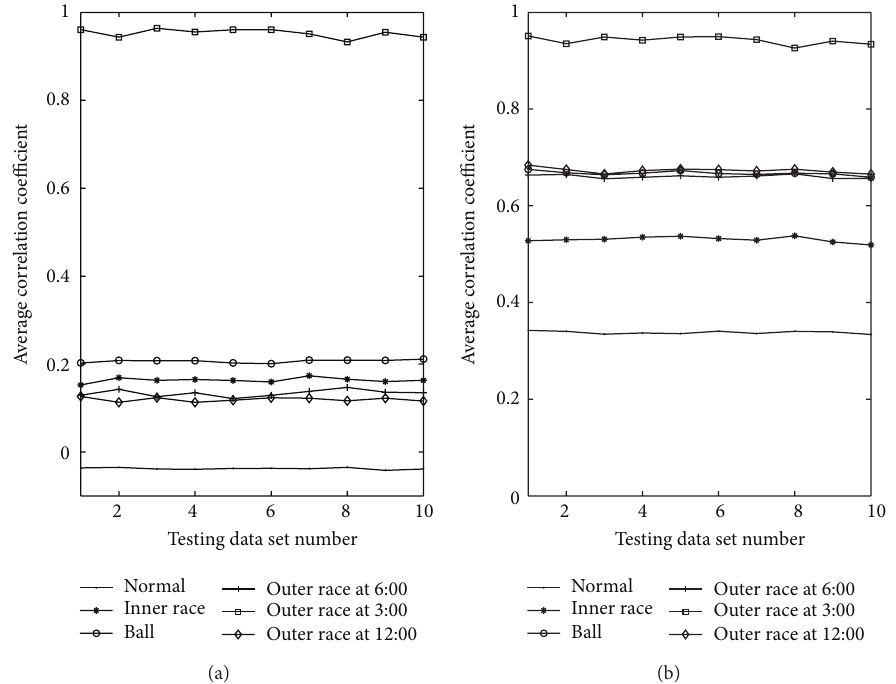
Figure 8: Detection results of data set A with an outer fault located at 3:00 according to morphology spectrum correlation analysis: (a) signal based triangular SE; (b) flat SE.